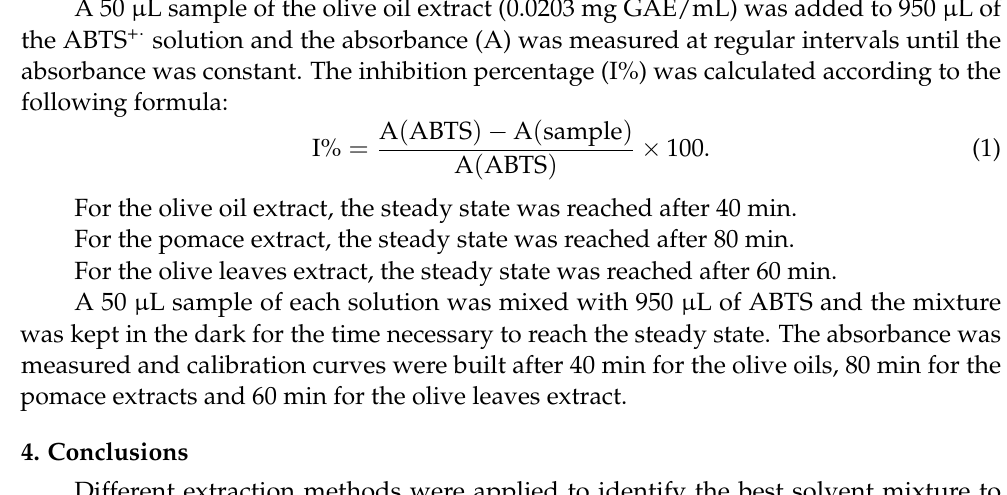
Figure S3: calibration curve of oleocanthal for HPLC quantification, Figure S4: calibration curve of gallic acid, Figure S5: Determination of the stationary state of ABTS for sample 2, Figure S6: Determination of the stationary state of ABTS for pomace extract, Figure S7: Determination of the stationary state of ABTS for olive leaves extract, Figure S8: calibration curve of